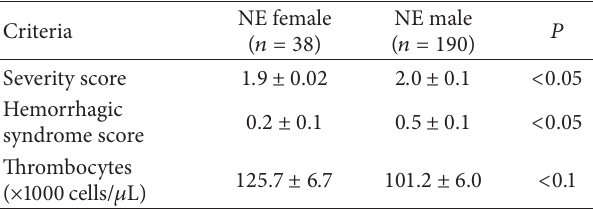
Table 5: Clinical presentation of NE patients based on gender.